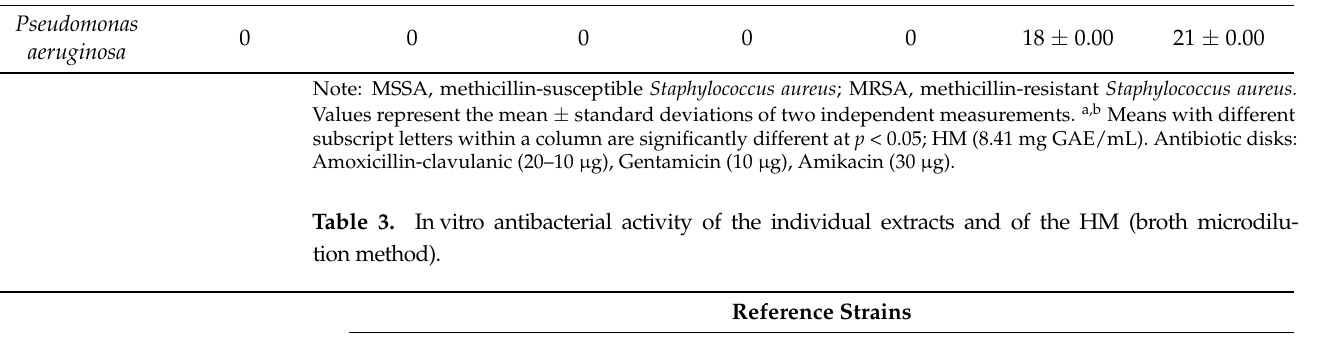
Zone of Inhibition (mm)